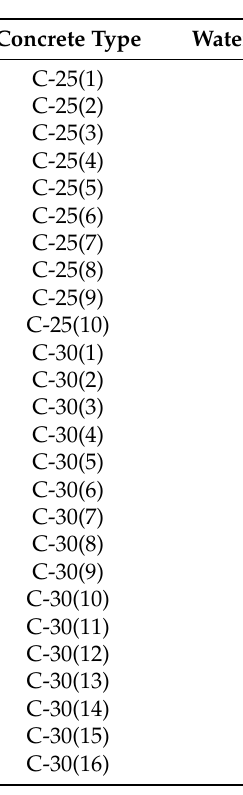
Table 3. Concrete unit costs for C-25 and